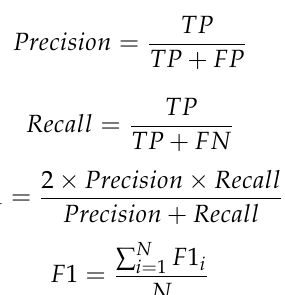
Figure 9. Illustration of the training flow of the Merge Strategy.